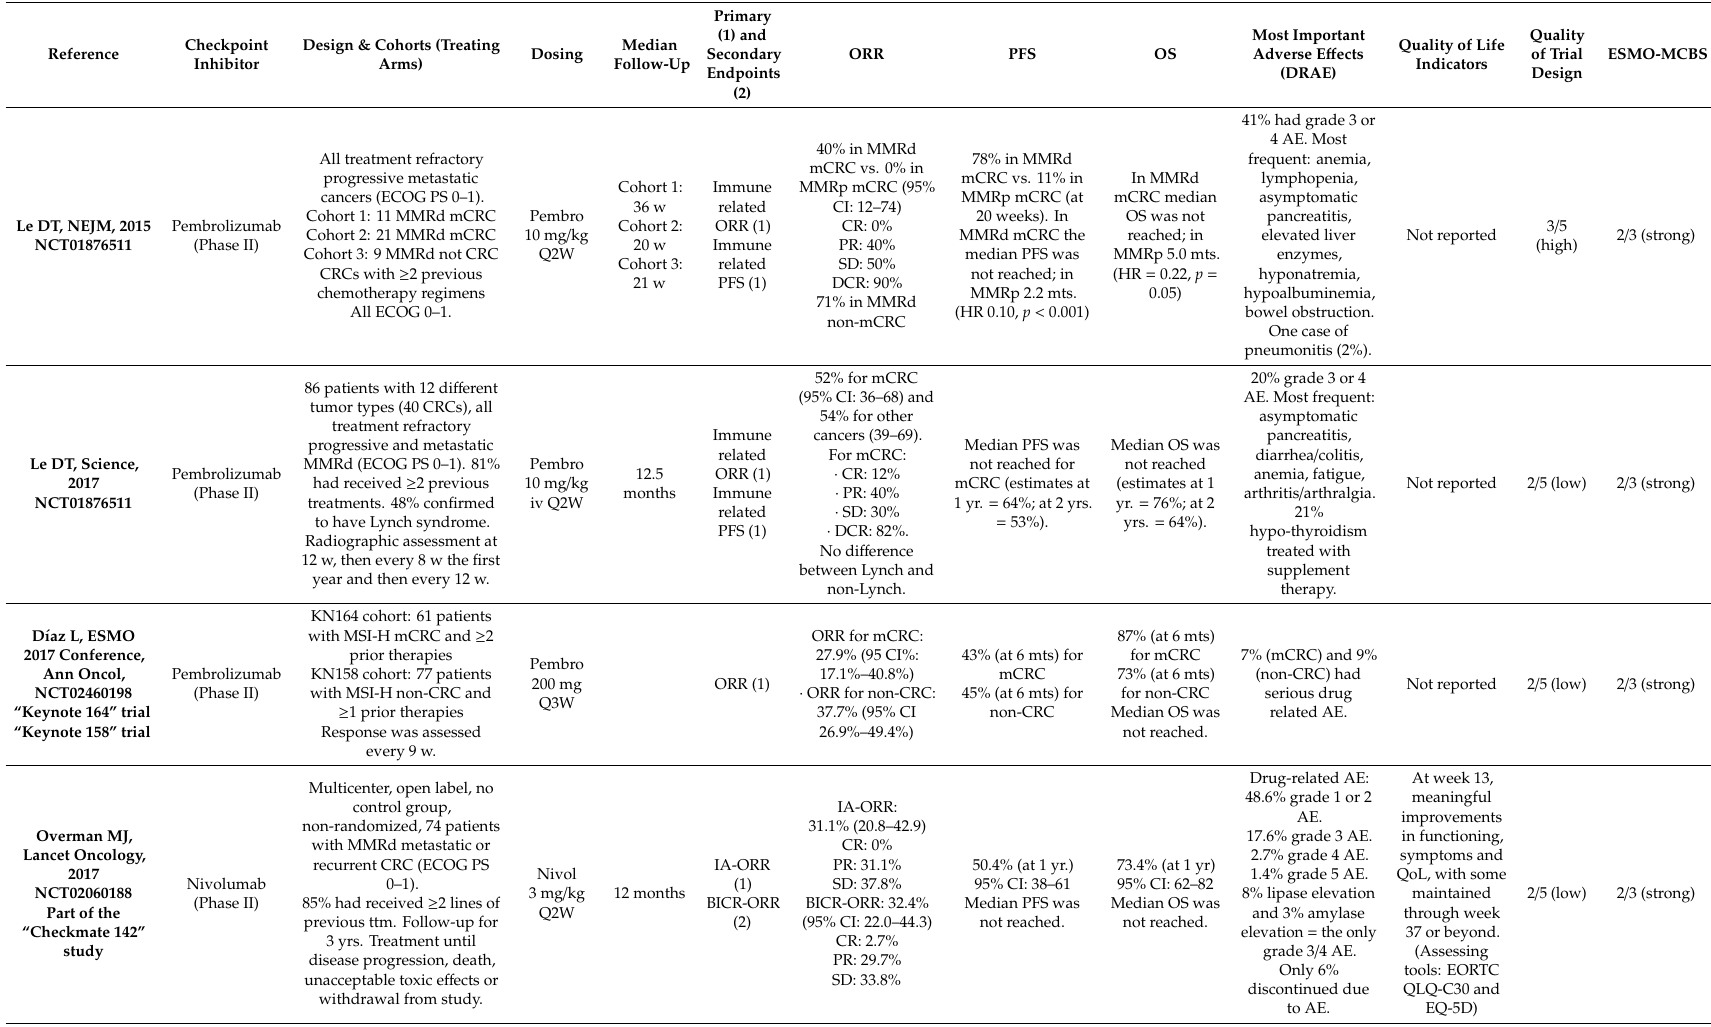
Table 1. Published and / or presented trials with checkpoint inhibitors in metastatic colorectal